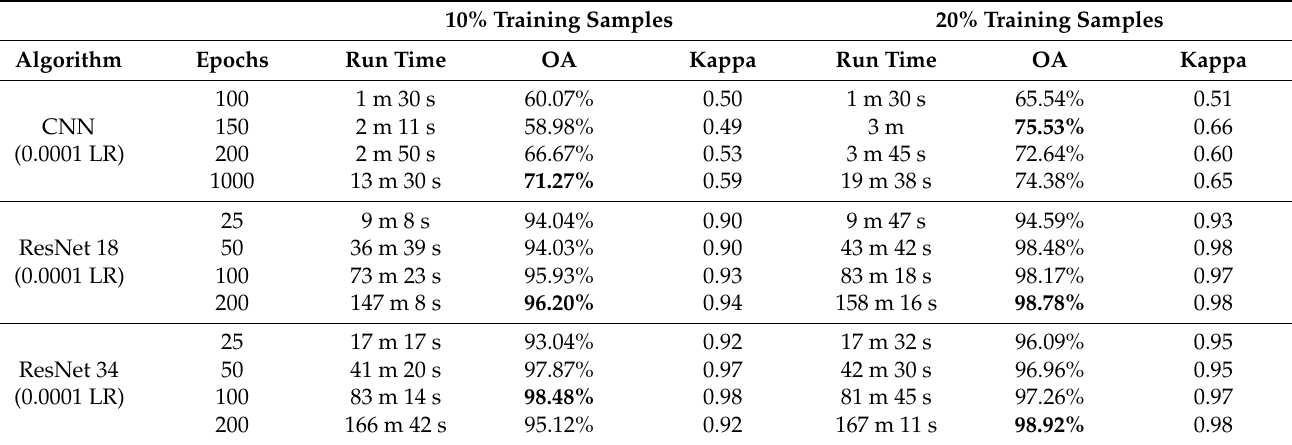
Table 4. Comparison of overall accuracy, Kappa statistic, and run time for CNN, ResNet 18, and ResNet 34 with four different epoch sizes, two different training sizes, and no augmentation.